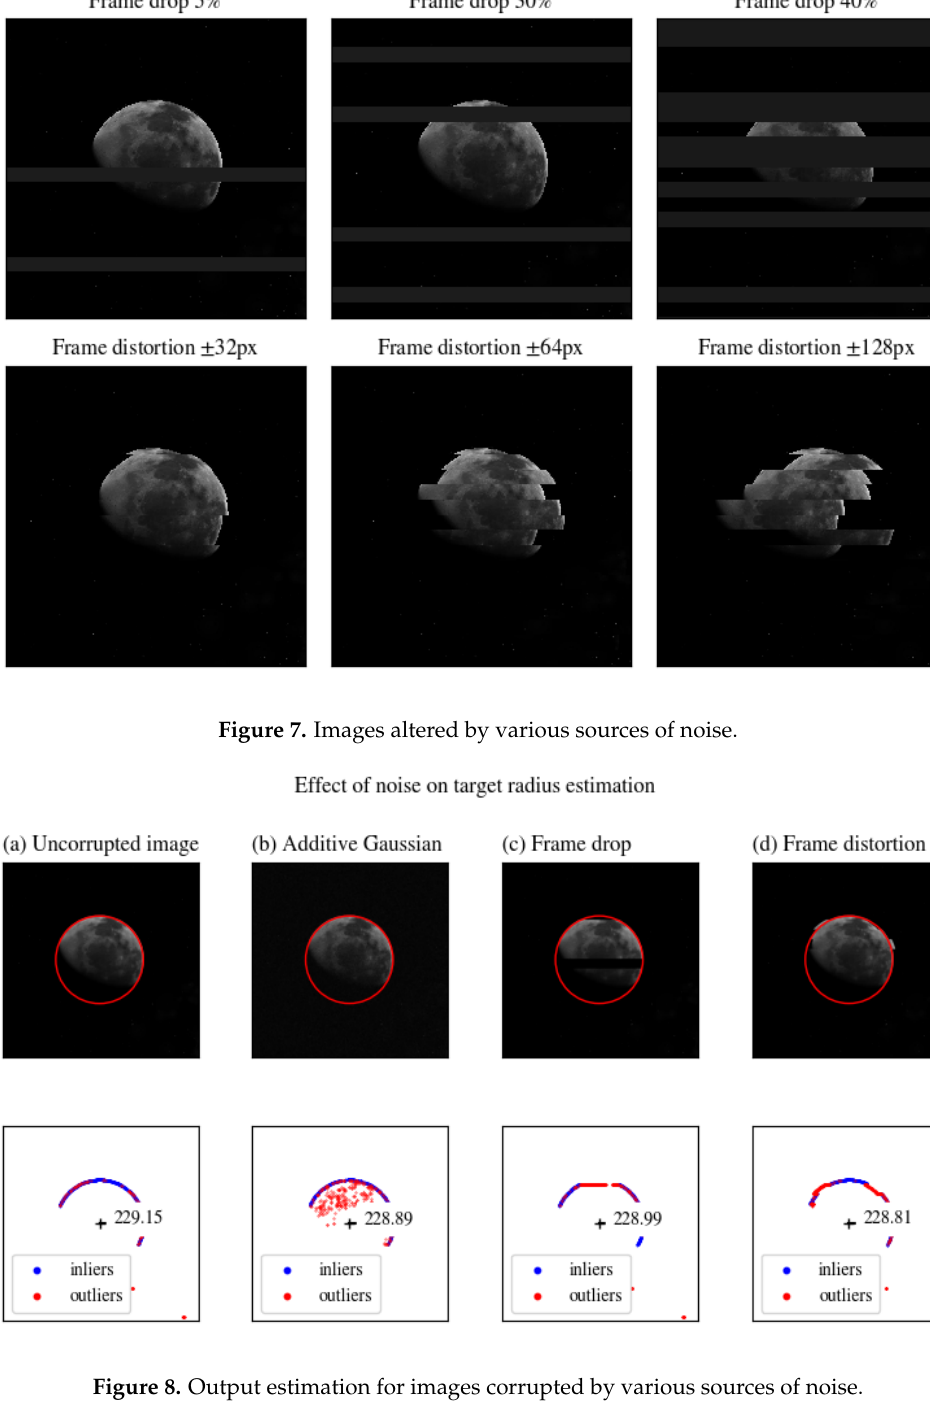
Figure 8. Output estimation for images corrupted by various sources of